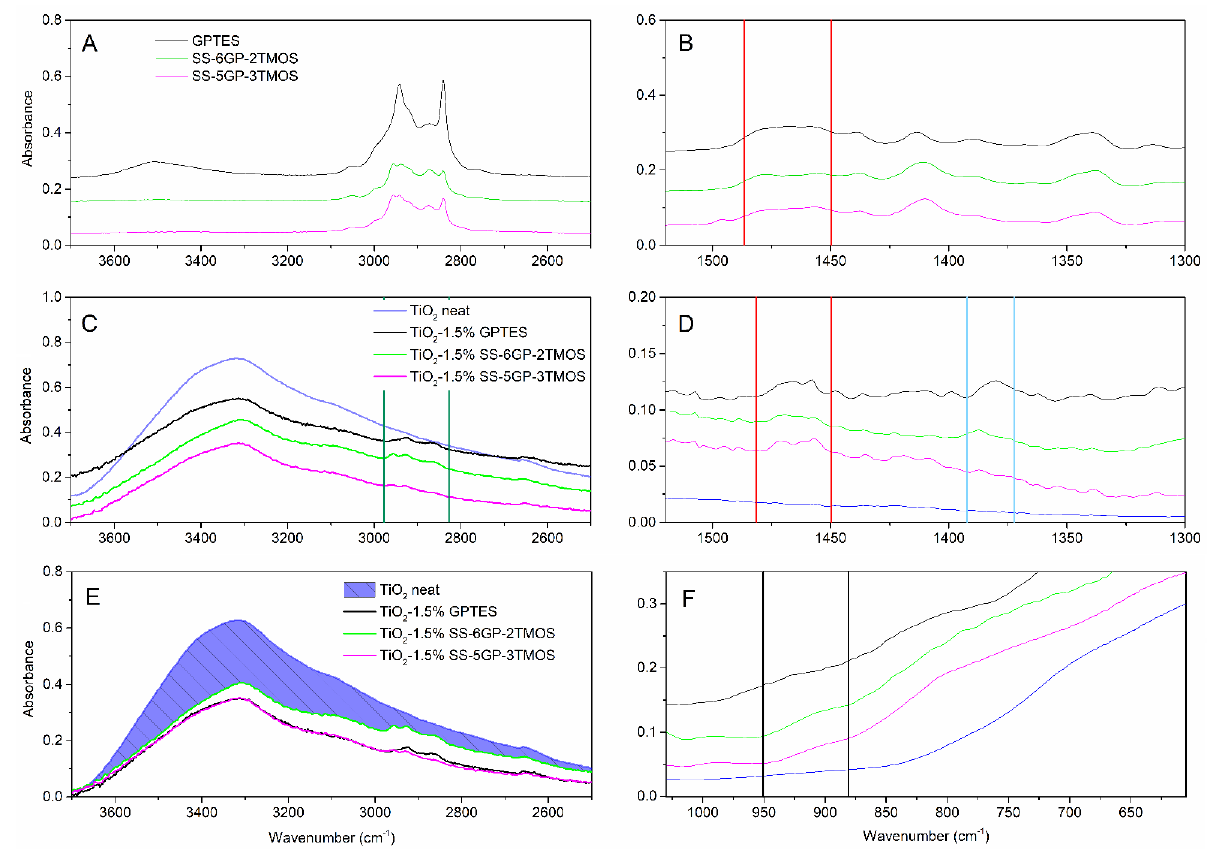
Figure 5. FT-IR of glycidyl-derived silane coupling agents ( A , B ), pristine TiO 2 and TiO 2 modified thereof ( C – F ). Red lines represent the region of oxirane ring vibrations, the blue lines—the diol vibrations, green ones—C-H vibrations, black ones—Ti-O-Si vibrations.